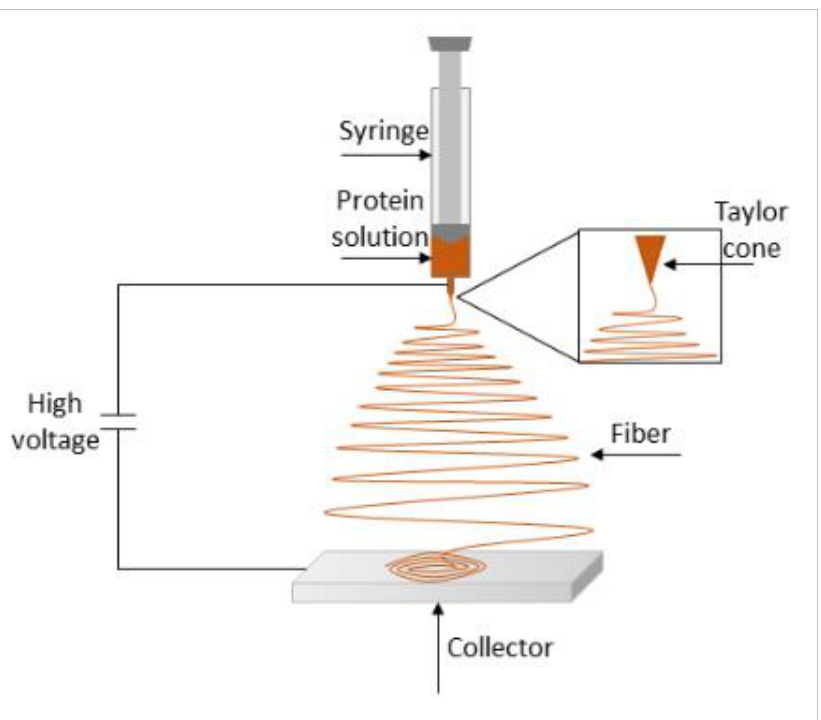
Figure 3. Principle and typical setup of electrospinning.